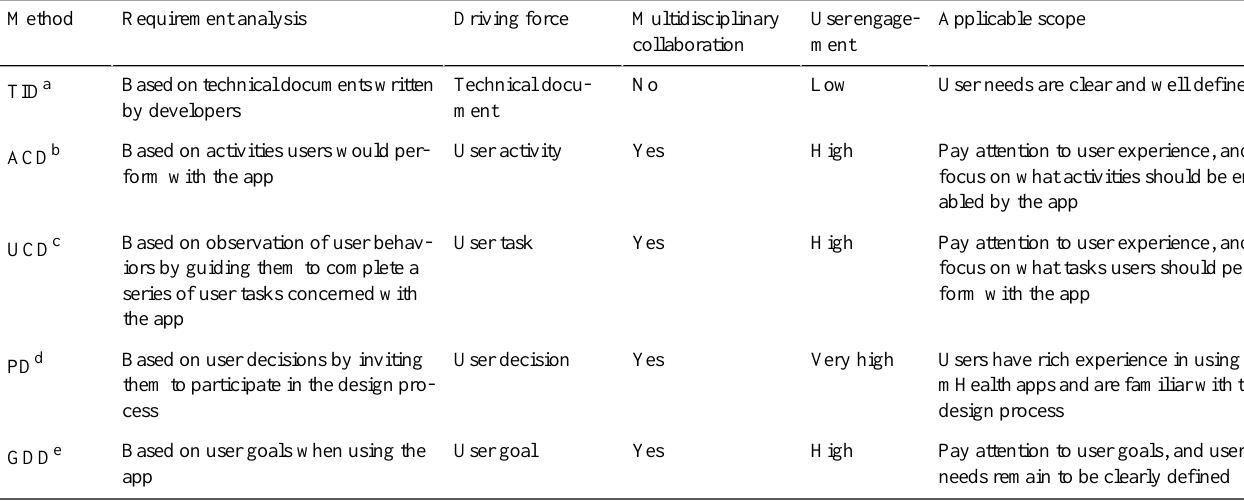
Table 1. Summary of common design methods for mHealth apps.